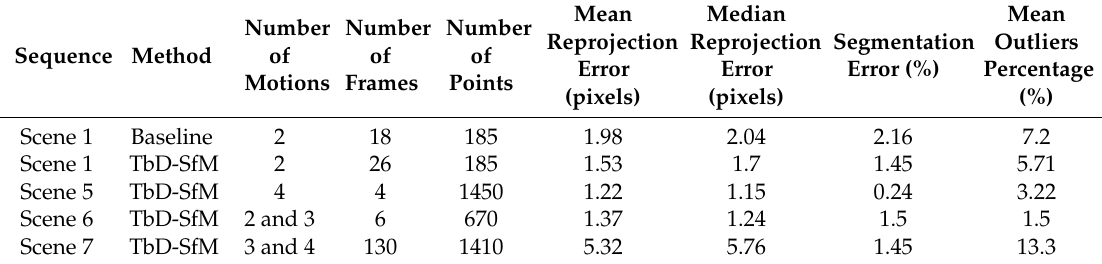
Table 8. Results reported for the KITTI